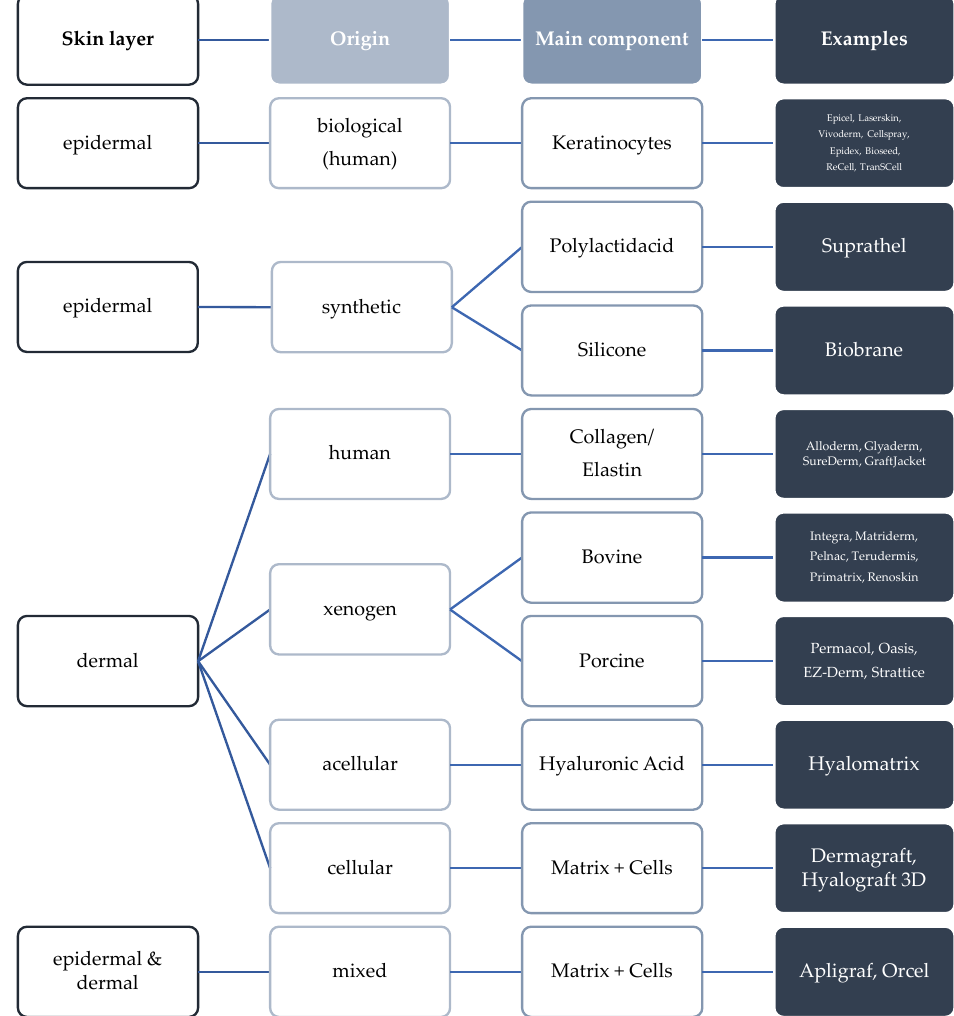
Figure 1. Overview of currently used skin substitute materials [7]. Depending on which skin layer is to be restored, a distinction is made between epidermal, dermal, and combined skin substitutes. The requirements for a dermal skin substitute are more challenging than for an epidermal skin substitute, which is mainly concerned with the rapid restoration of the epidermal structures. A dermal replacement should meet the best possible natural requirements of the body’s own dermis. This includes the reconstruction of the anatomy as well as the associated physiological function. Replacement materials are designed with their basic structure to control scarring, contraction, and pain in a positive sense by reducing healing time. All the sample materials mentioned are ®